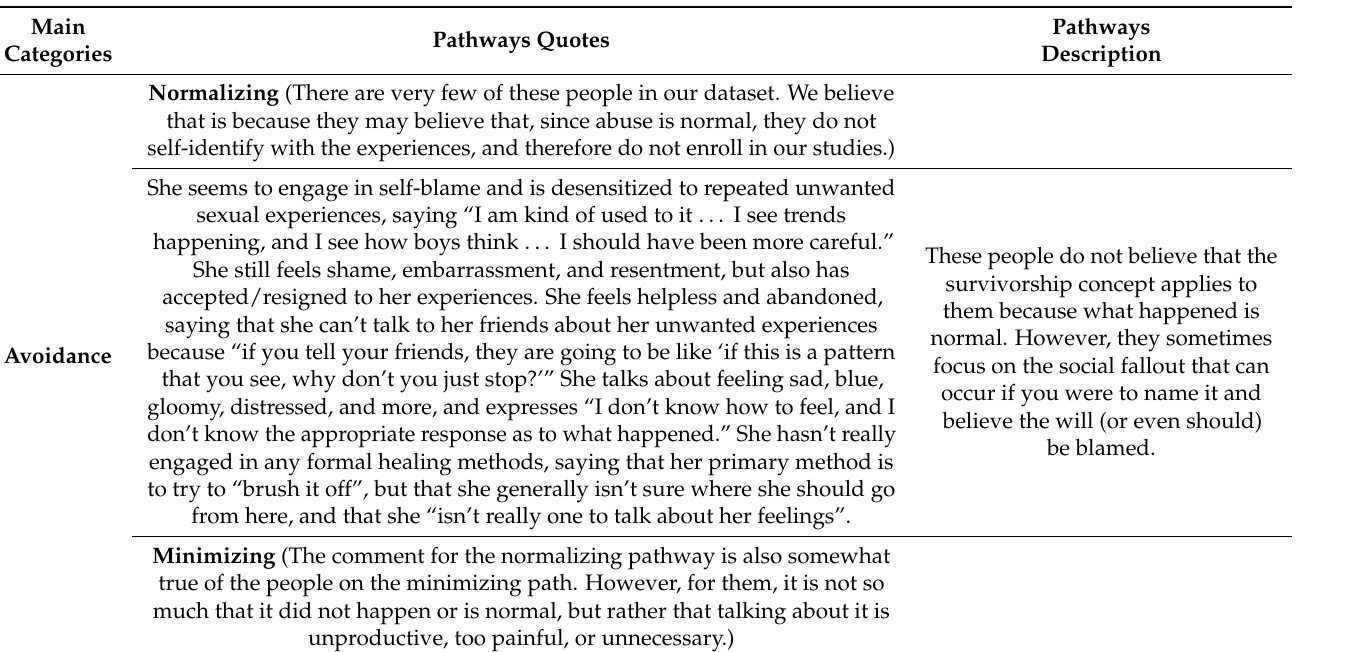
Table 2. Quotes from the narrative rating